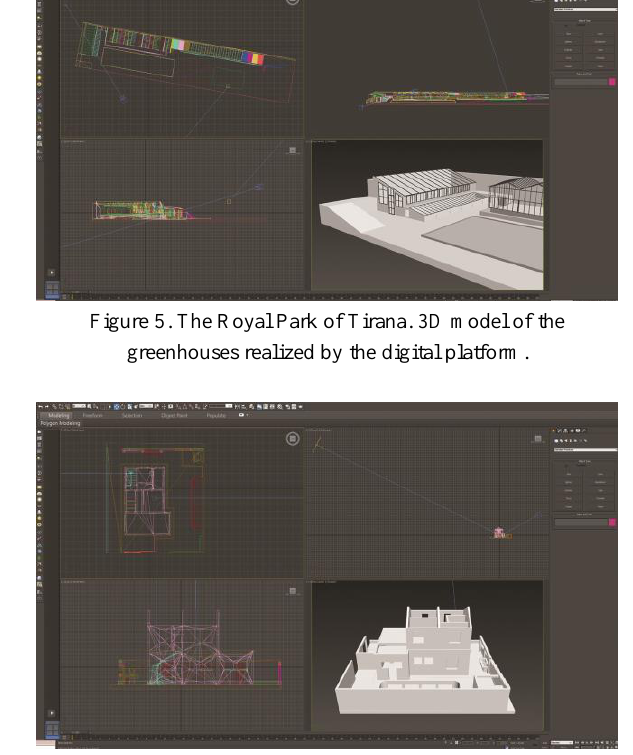
Figure 6. The Royal Park of Tirana. 3D model of the gardener's house made by the digital